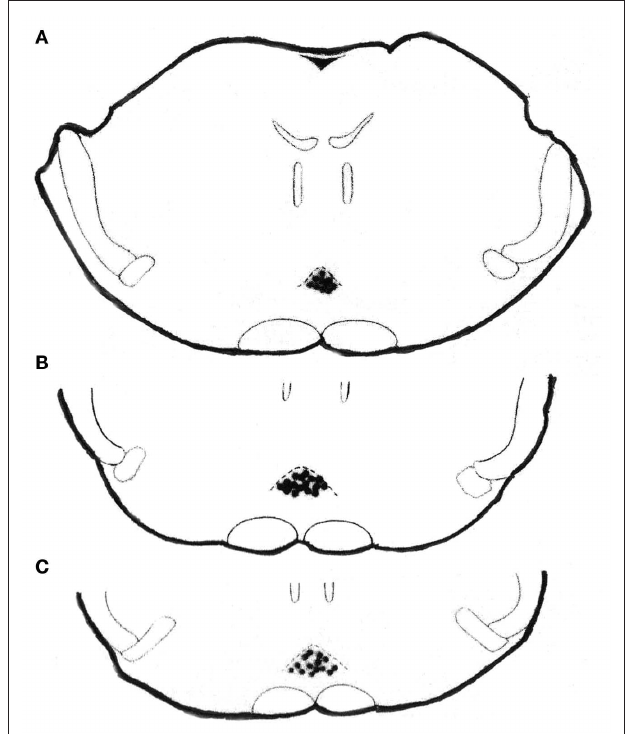
Figure 1 | Histologically verified microinjection sites for analgin, clodifen, ketorolac, xefocam, or saline in the NrM, in transverse sections simplified from Paxinos and Watson (1997) atlas. Rats were microinjected with NSAIDs or saline for 5 days to induce tolerance. The distance from the bregma is − 9.16 mm (A) , − 9.68 (B) , and − 9.8 (C) ,